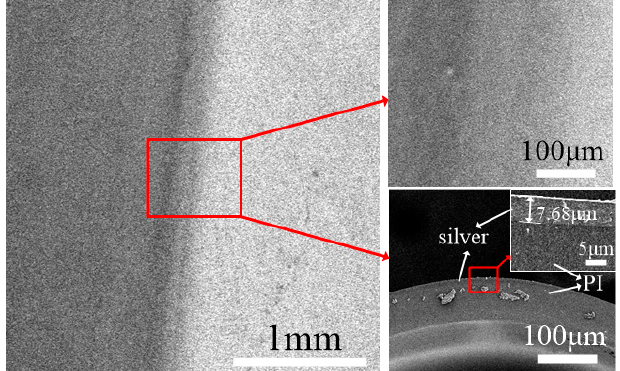
Figure 13. Top and cross-sectional SEM images of the film (folded).